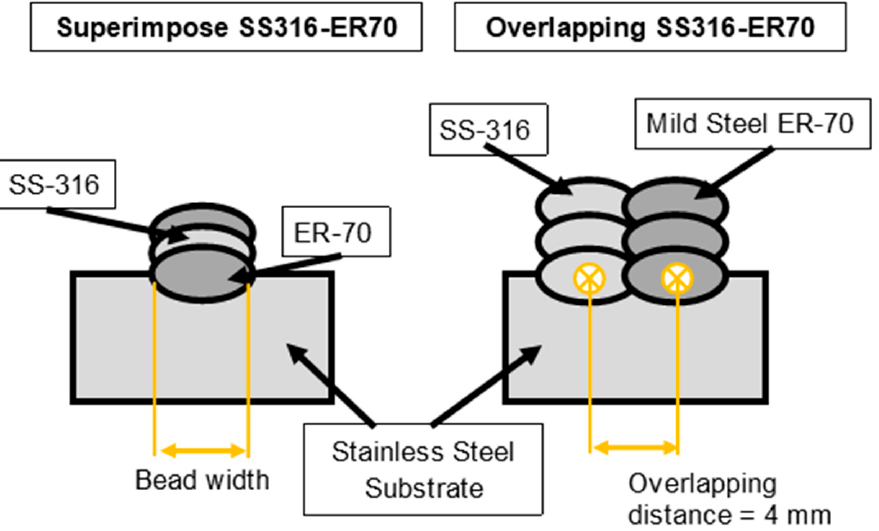
Figure 2. Two-dimensional illustration with dimensions of features for both strategies. To carry out the mechanical characterization tests, the ISO 6892-1 standard [16] was followed. Specimens were removed from the fabricated walls as deposited. The test di- rection of the specimen is the forward direction of the torch. Four tensile test specimens were purchased in total. Two for each different wall. The terminals of the test specimens have a metric 6 thread. Mechanical tests at room temperature were performed at a speed of 1 mm/min, using an Instron 5585H machine (Norwood, MA, USA) equipped with a load cell (100 kN). In this work, metallographic samples were extracted by conventional machining of the inner surface of additive manufactured walls. The samples were then mechanically polished and etched with a 2% solution of Nital—nitric acid and ethanol—to reveal the grain structure. Finally, microhardness tests were carried out on the two fabri- cated walls. In the different regions corresponding to the deposition of each of the materials. The microhardness measurement was carried out by using an EMCOTEST DuraScan G5 microhardness tester (Kuchl, Austria), applying a load of 98 N (10 kgf). Figure 3 shows the arrangement of the samples and the industrial drawing correspond- ing to the standard. In the preliminary tests, 6 specimens were tested in each direction in the case of ER70 and 4 specimens in the case of SS 316L. For the bimetallic wall specimens, 4 specimens were tested in the horizontal direction. The horizontal direction corresponds to the direction of torch advancement and the vertical direction to the direction of wall growth. For the manufacture of the specimens, a rectangle of the specimen is removed by saw cutting, and the roughing, finishing and thread cutting are carried out on a nu- merically controlled lathe. The aim is to analyze the influence of grain anisotropy and the existence of interfaces in the different layers due to the heating–cooling phases on the mechanical